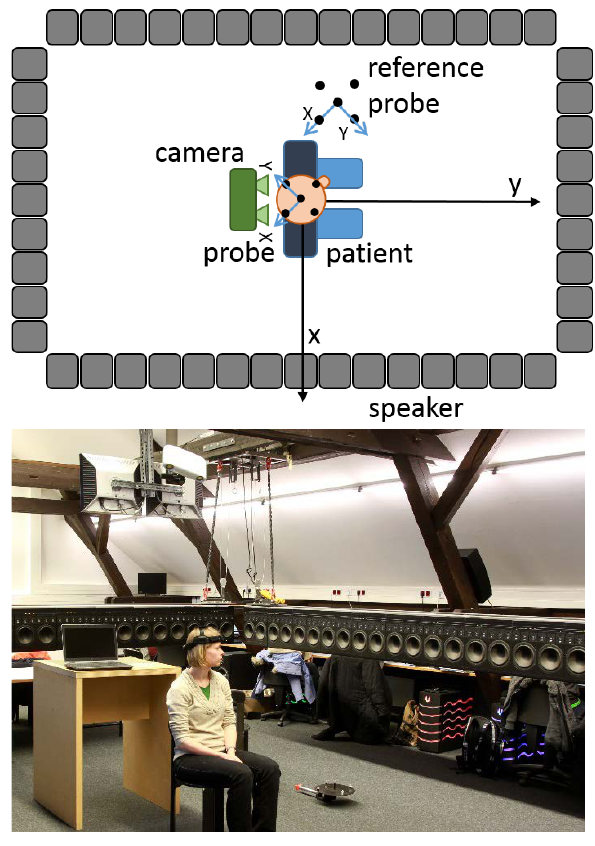
Figure 6. Patient is sitting in the center of the wave field synthesis system. The stereo camera above observes the points on the patient's head and the reference system on the floor simultaneously